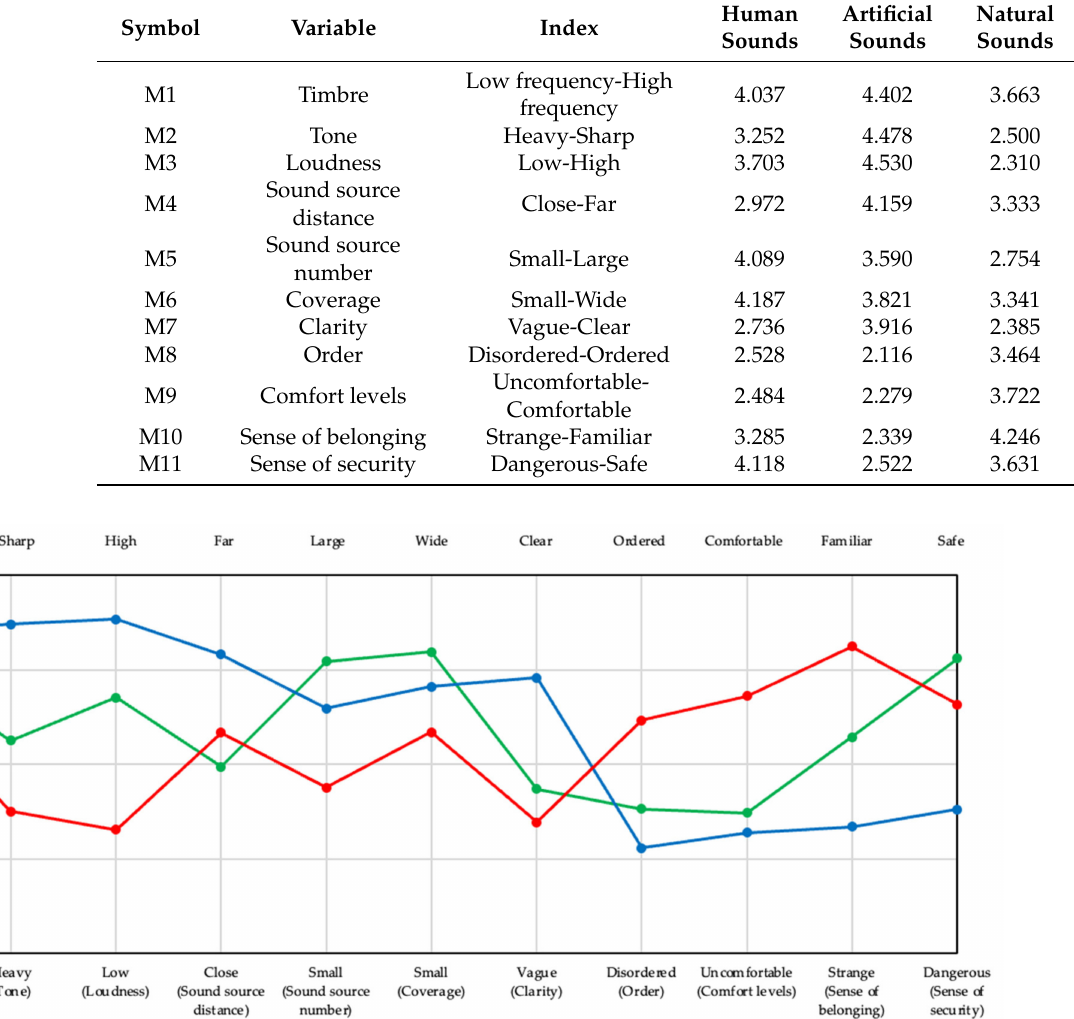
Table 5. Scale of the semantic differences for different sound types.